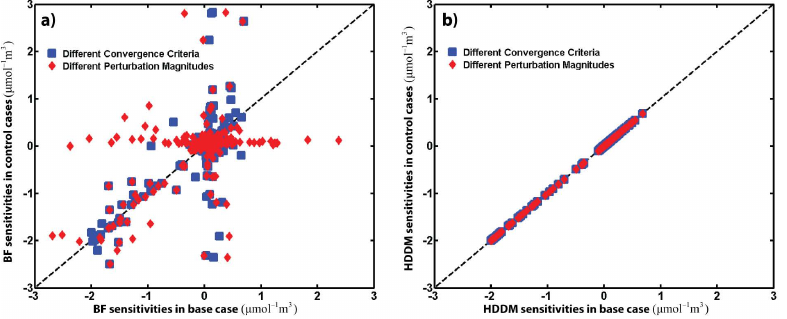
Fig. 3. Second-order sensitivity coefficients of aerosol nitrate to total sulfate in stand-alone ISORROPIA calculated by (a) BF and (b) HDDM under three conditions: (1) base case, where the perturbation used by BF ( 1p) = 1% and the convergence criteria of ISORROPIA ( 1η) = 1 × 10 − 10 ; 2) control case 1 (blue squares) with 1p = 1% and 1η = 1 × 10 − 3 ; and 3) control case 2 (red diamonds) with 1p =0.1% and 1η = 1 × 10 − 10 . The default value of the convergence criteria for ISORROPIA is 1 × 10 − 6 . Results from the two control cases are compared to those from the base case. The dashed line is the one-to-one line.